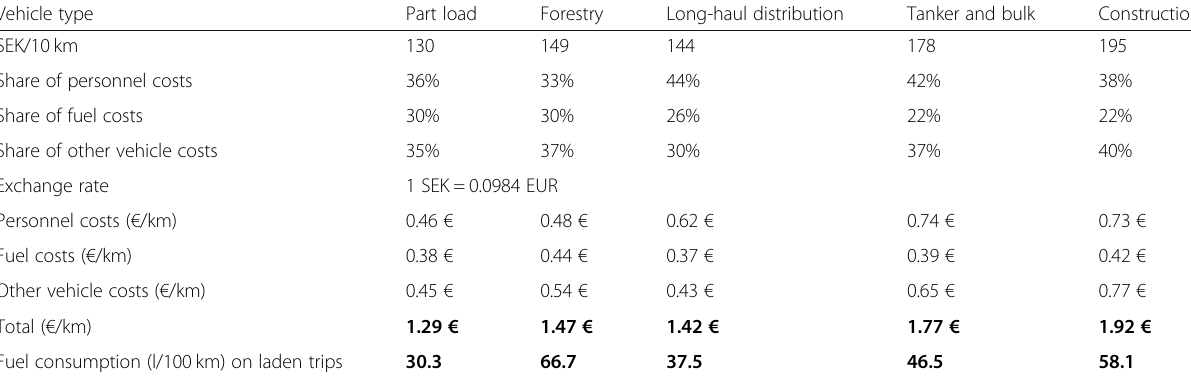
Table 2 Operating cost used to calculate cost savings (based on Vierth et al. [33], except fuel consumption on laden trips calculated from GTRS data using methodology by Liimatainen & Pöllänen